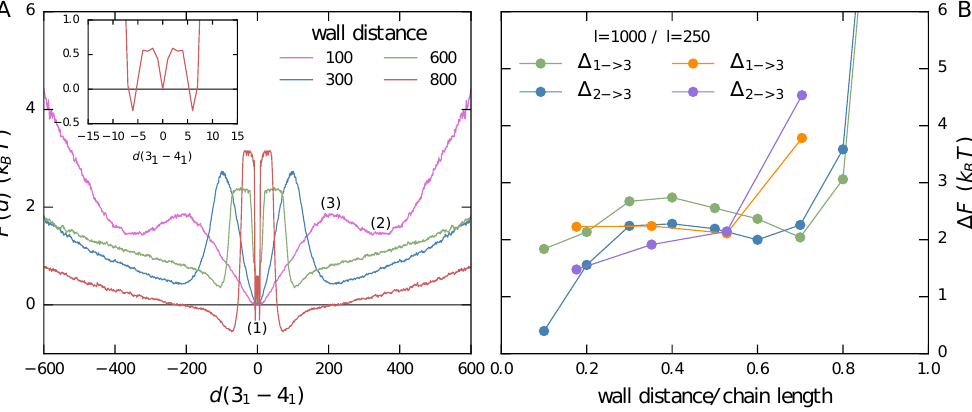
Figure 4. Free energy landscape. ( A ) Free energy landscapes of the knot distance for different end-to-end distances R ee . The inset shows the triple peak structure of the intertwined states at the largest wall distance (800) that was already observed in shorter chains [42]; ( B ) Free energy barriers for different wall distances. The differences in the free energy distribution between the local maximum of the barrier (3) and the local minima corresponding to the intertwined state (1) as well as the separated state (2) are plotted in green and blue for l = 1000 and in orange and purple for l = 250